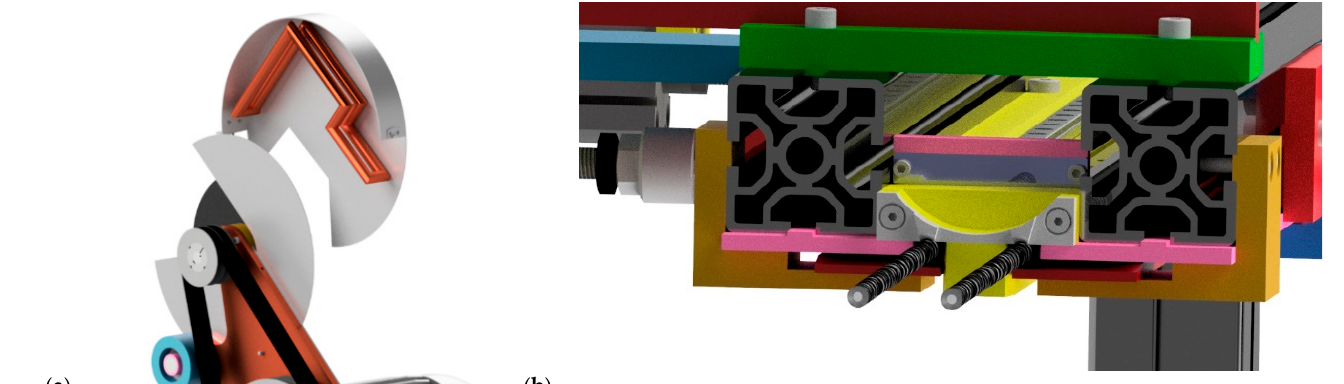
Figure 16. Cutting disk cooler system ( a ) and schematic of the cutting rulers ( b ).